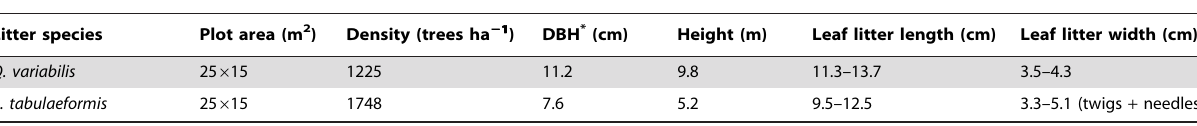
Table 1. Forest stands and litter characteristics